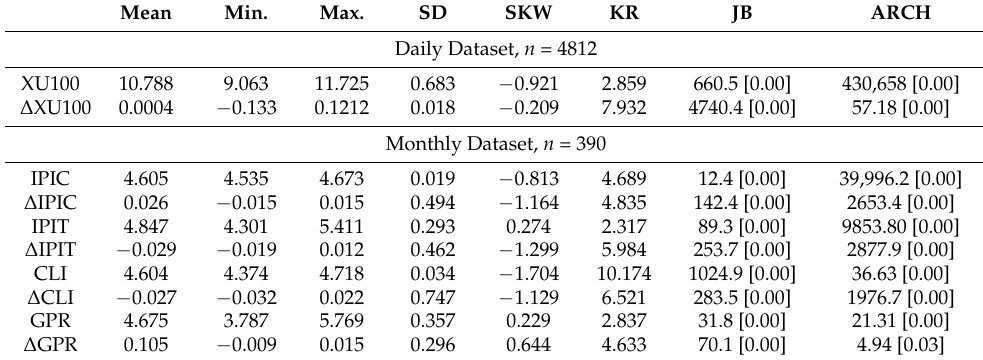
Table 2. Descriptive